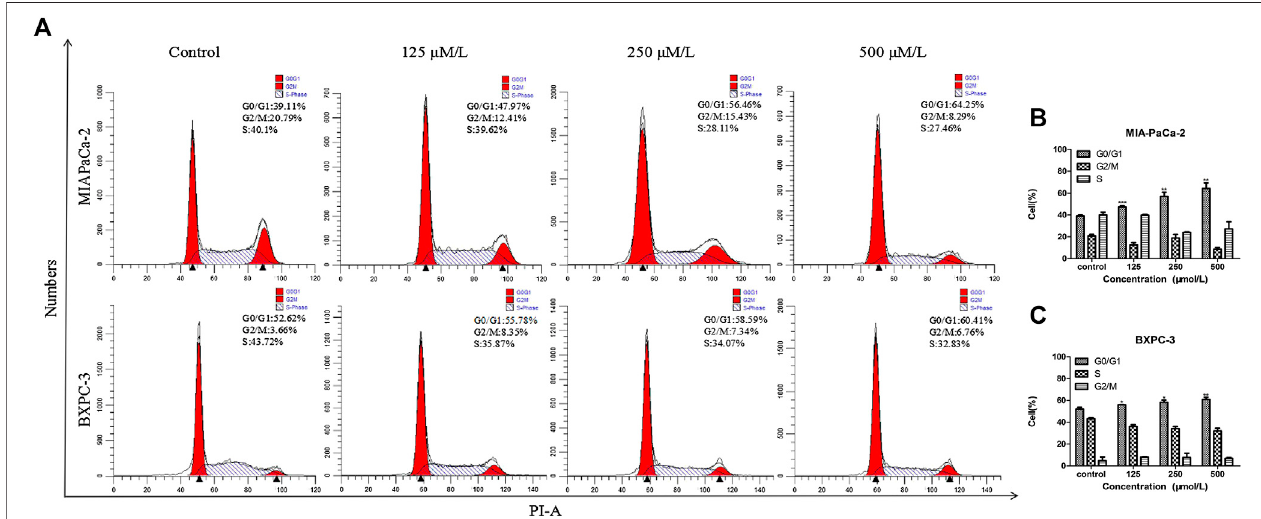
FIGURE 2 | β -Sitosterol (BS) affects cell cycle progression in pancreatic cancer cells. (A – C) MIA-PaCa-2 and BXPC-3 cells were treated with different concentrations ofBSfor48 h. G0/G1 cell cycle arrest wereobservedin MIA-PaCa-2 and BXPC-3cells. All dataare depicted asmean ± SD ( n (cid:1) 3;* p < 0.05; ** p < 0.01; *** p <